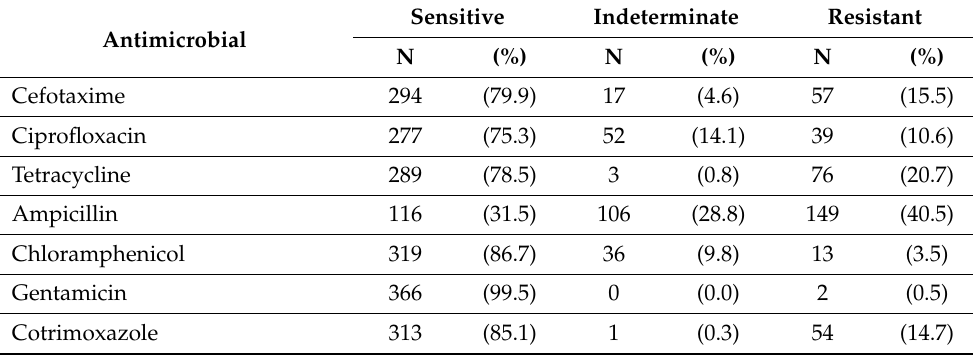
Table 2. Patterns of resistance among the E. coli isolated from the fecal samples of adults in Dhulikhel municipality in Nepal from September to December 2021 (N = 368).